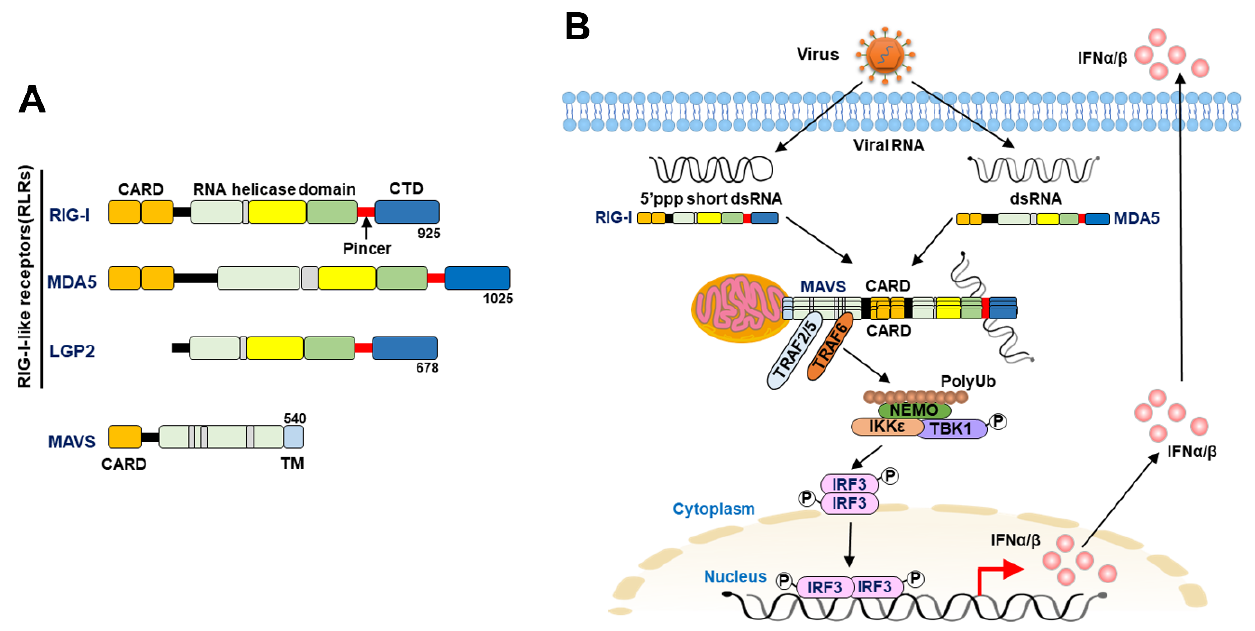
Figure 1. Signaling pathway of retinoic acid-inducible I (RIG-I)-like receptor (RLR) antiviral immunity: ( A ) Domain structure of RLRs, including retinoic acid-inducible I (RIG-I), melanoma differentiation association gene 5 (MDA5), laboratory of genetics and physiology 2 (LGP2), and the downstream effector mitochondrial antiviral signaling (MAVS). Among them, RIG-I, MDA5, and LGP2 contain the central helicase domain and C-terminal domain (CTD). There are two caspase activation and recruitment domains (CARDs) located within the N-termini of RIG-I and MDA5. MAVS has one N-terminal CARD that is able to associate with the CARDs of RIG-I and MDA5 and a C-terminal transmembrane domain for targeting to the mitochondrial outer membrane. ( B ) Activation of RLR antiviral signaling. During virus infection, the binding of viral RNAs induces conformational changes in RIG-I and MDA5. The free CARDs of RIG-I and MDA5 undergo self-oligomerization and interact with the CARDs of MAVS on mitochondria. The formed MAVS aggregates in turn to recruit the ubiquitin E3 ligases (TNF) receptor-associated factor 2 (TRAF2), TRAF5, and TRAF6, which produce polyubiquitin chains. The polyubiquitin chain then induces the recruitment of nuclear factor kappa-light-chain-enhancer of activated B (NF-kB) essential modulator (NEMO), which subsequently activates TANK binding kinase 1 (TBK1) to phosphorylate interferon response factor 3 (IRF3). Phosphorylated IRF3 then translocates